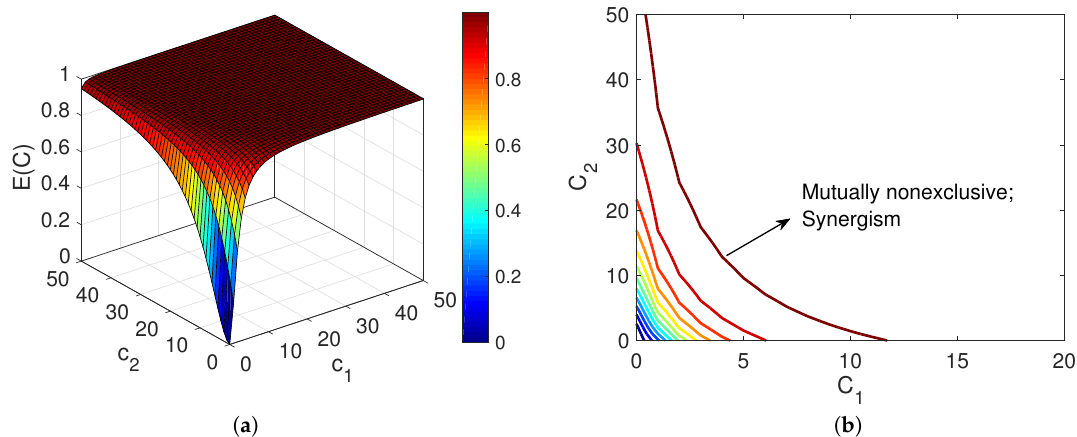
Figure 3. Combination of mutually nonexclusive agents: ( a ) The effect versus the concentration of the combining drugs; ( b ) Dosage of drug 2 versus drug 1 with respect to the combination effect which represents